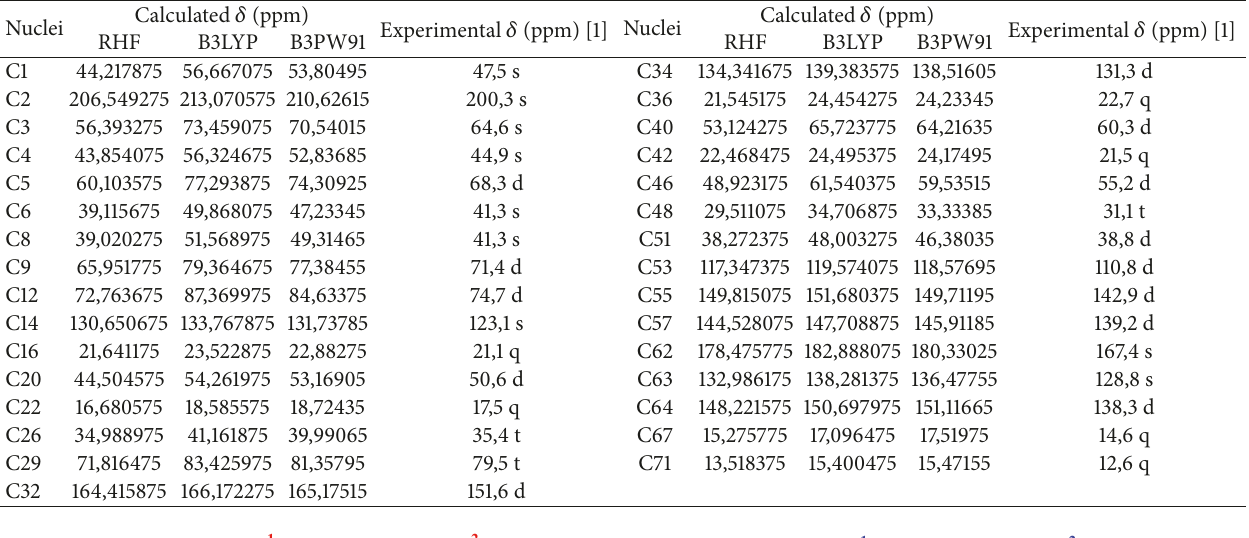
Table 8: Experimental and calculated 13 C NMR chemical shift 𝛿 (ppm) of Rubescin E at the RHF, B3LYP, and B3PW91 levels in chloroform solution using the 6-311++G(d,p) basis set.